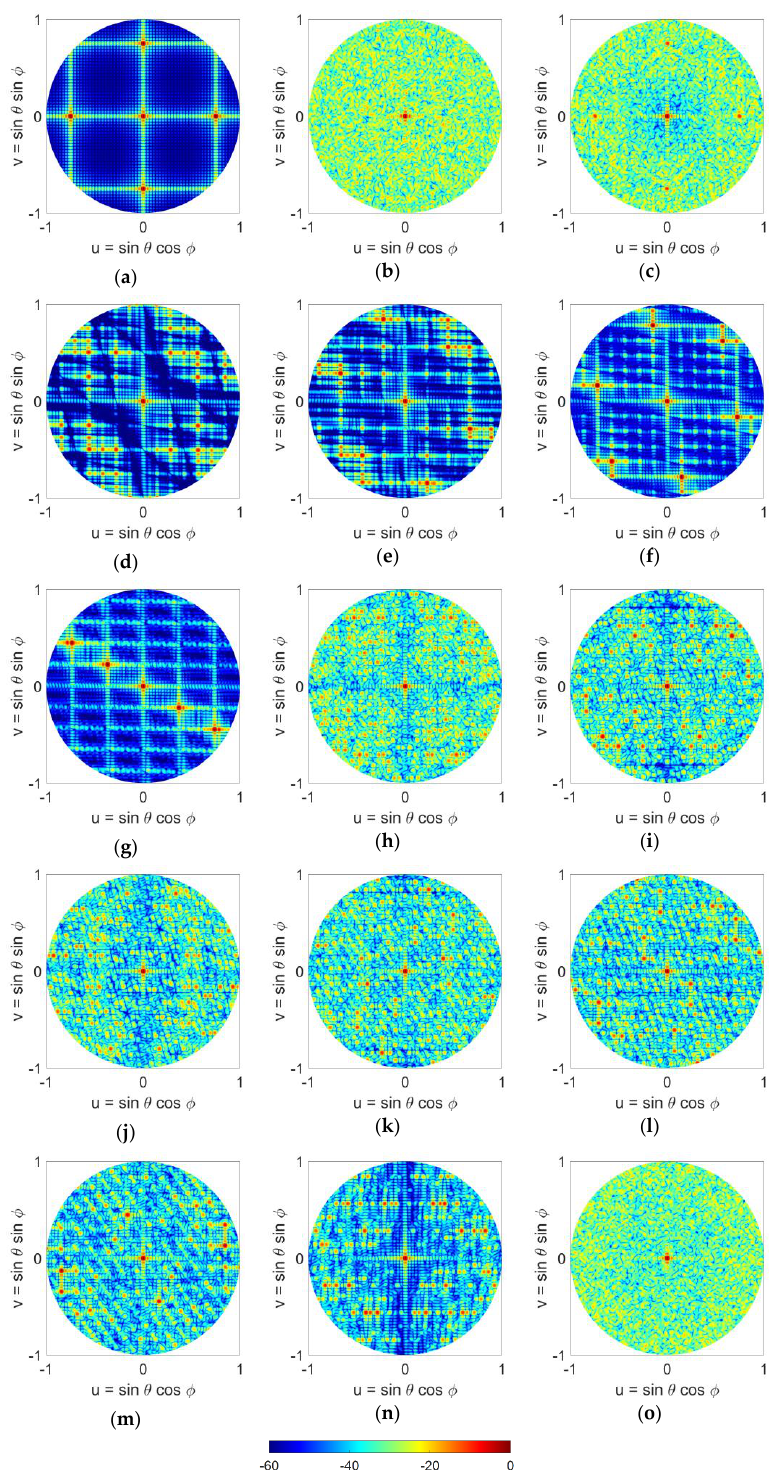
Figure 5. Normalized power patterns of the antenna arrays with different element distributions in the u-v space: ( a ) uniform, ( b ) random, ( c ) random with jitter, ( d ) Hammersley (base 2), ( e ) Hammersley (base 3), ( f ) Hammersley (base 5), ( g ) Hammersley (base 7), ( h ) Halton (bases 2, 3), ( i ) Halton (bases 2, 5), ( j ) Halton (bases 2, 7), ( k ) Halton (bases 3, 5), ( l ) Halton (bases 3, 7), ( m ) Halton (bases 5, 7), ( n ) Sobol, ( o ) Poisson disk.